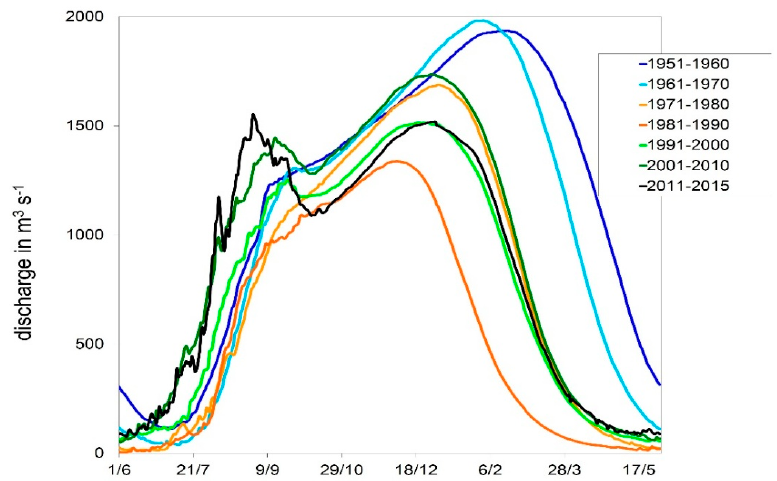
Figure 2. Decadal hydrographs of the Niger River at Niamey (x axis is time scale: 1/6 is 1 June, 17/5 is 17 May of the following year).